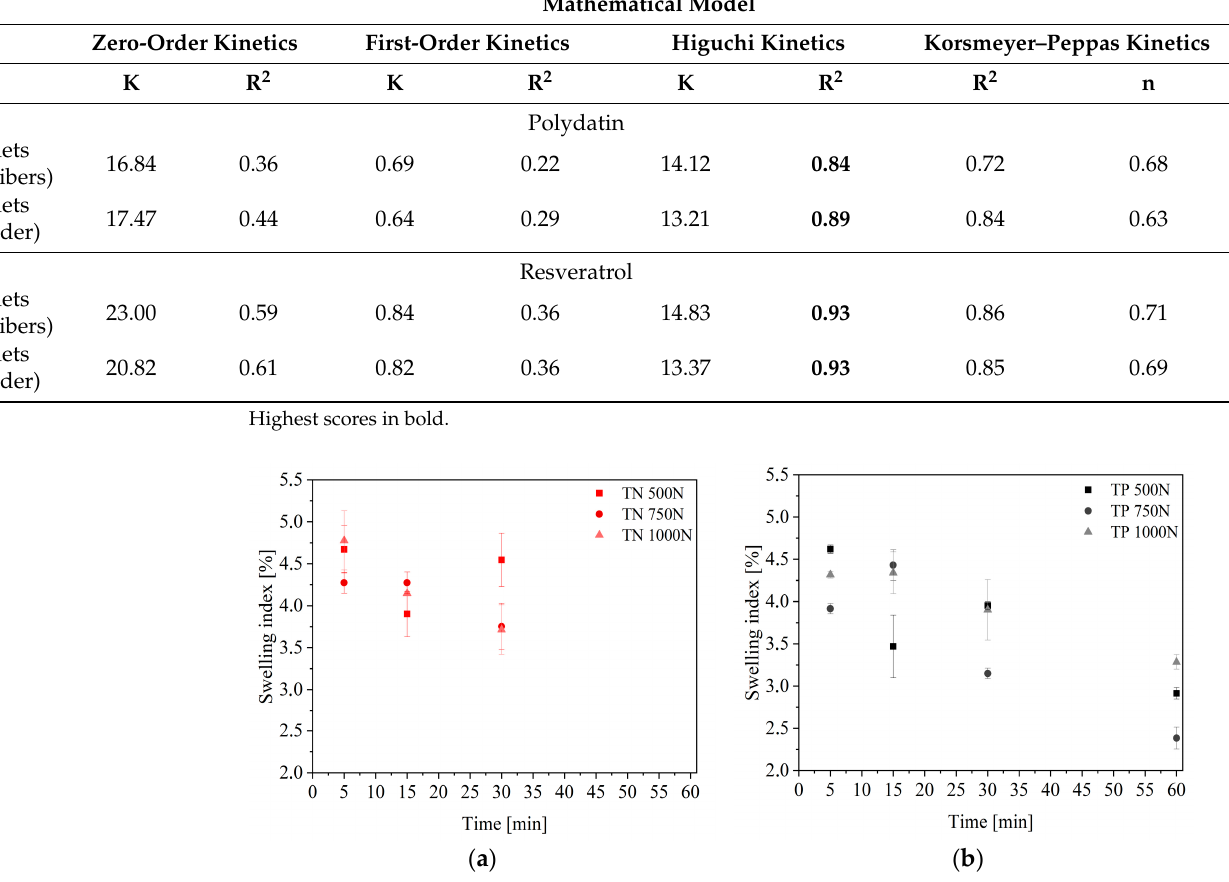
Figure 5. Swelling index of tablets produced from nanofibers ( a ) and powder ( b ).